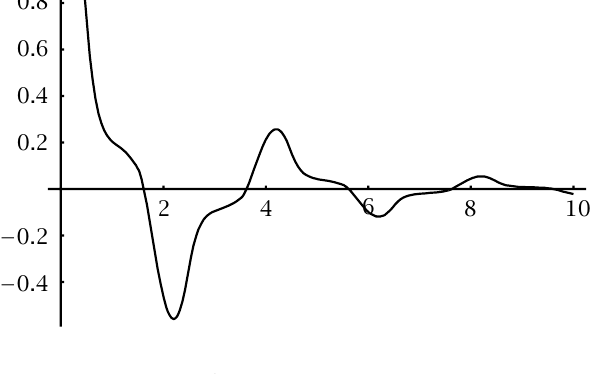
Figure 6.7 . T j (t) for b(t) = b cos (πt) , b = 3, d j = 4.